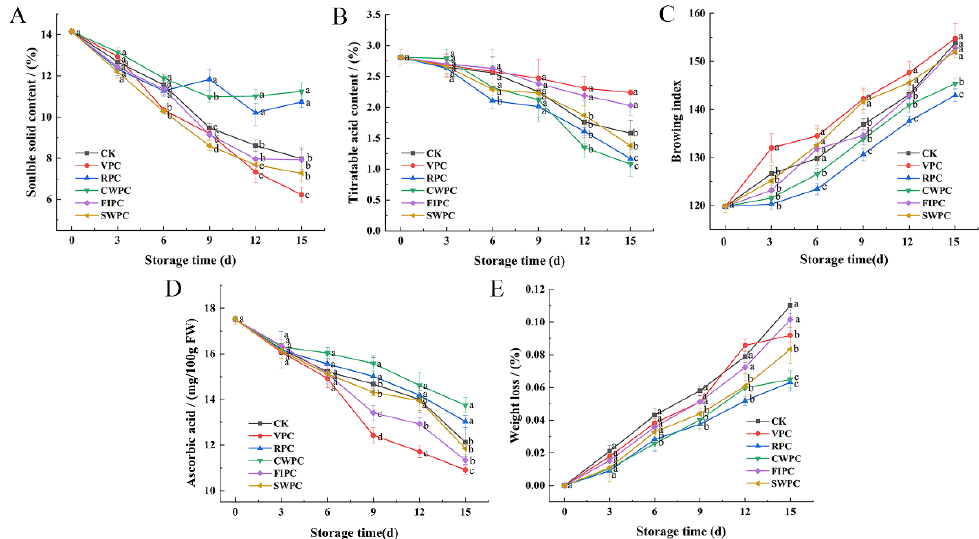
Figure 4. Changes in ( A ) soluble-solids content; ( B ) titratable acid content; ( C ) pericarp browning index; ( D ) vitamin C content; ( E ) weight loss of yellow peaches with different precooling methods during cold storage. The abbreviations CK, RPC, CWPC, SWPC, FIPC, and VPC in the figure correspond to control group, refrigerator precooling, cold-water precooling, strong-wind precooling, fluidized-ice precooling, and vacuum precooling, respectively. Values with different lowercase letters in the same column are significantly different ( p < 0.05).